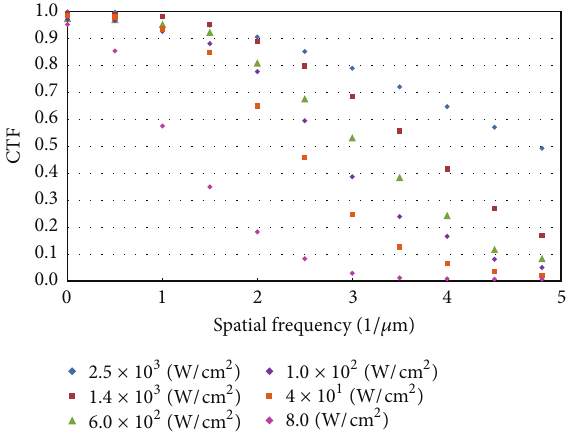
Figure 3: CTF curves measured with polarization interferometric nonlinear confocal